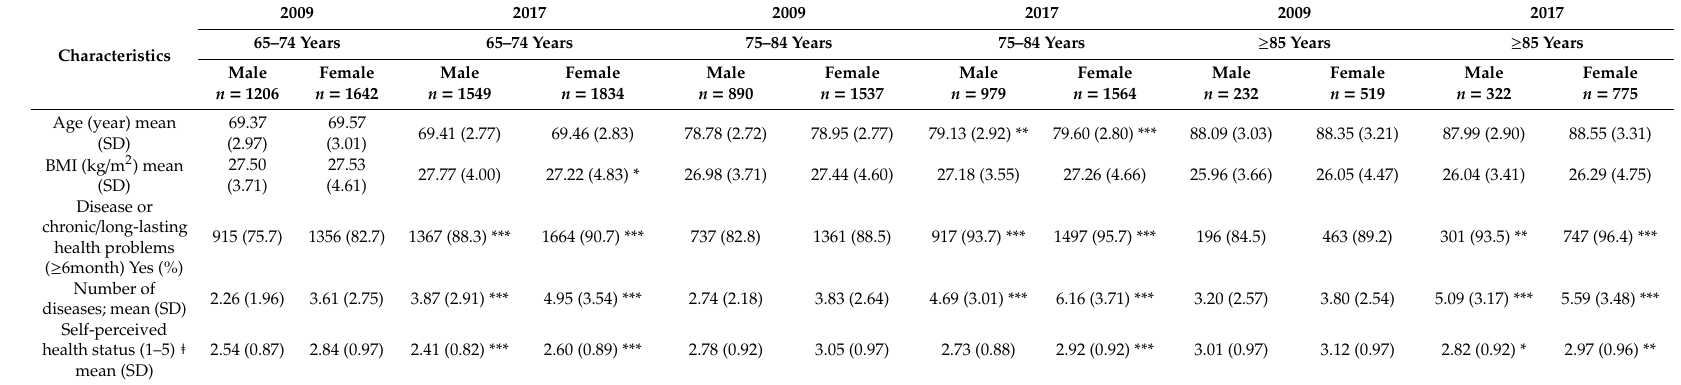
Table 3. Age, BMI, disease or chronic health problems, number of diseases, and self-perceived health status regarding survey year, age group, and sex.